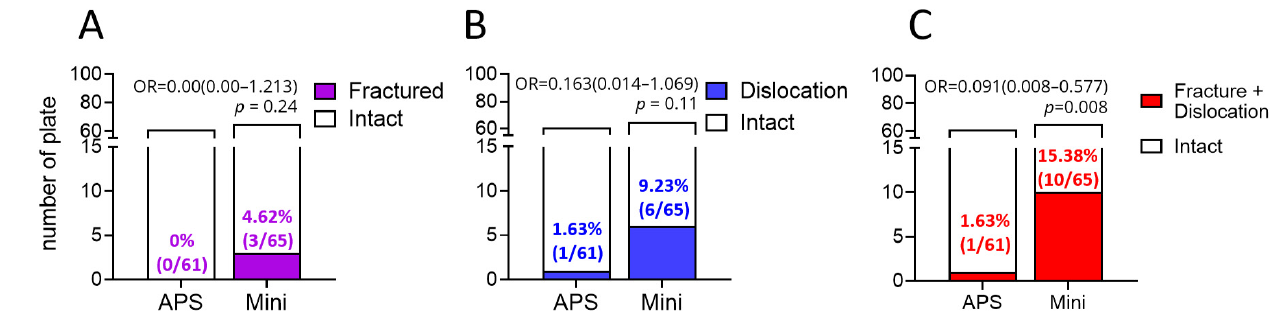
Figure 4. Comparison of fixation stability between the APS and Mini plates. The occurrences of ( A ) plate fracture, ( B ) screw dislocation, and ( C ) fracture plus dislocation. OR, odds